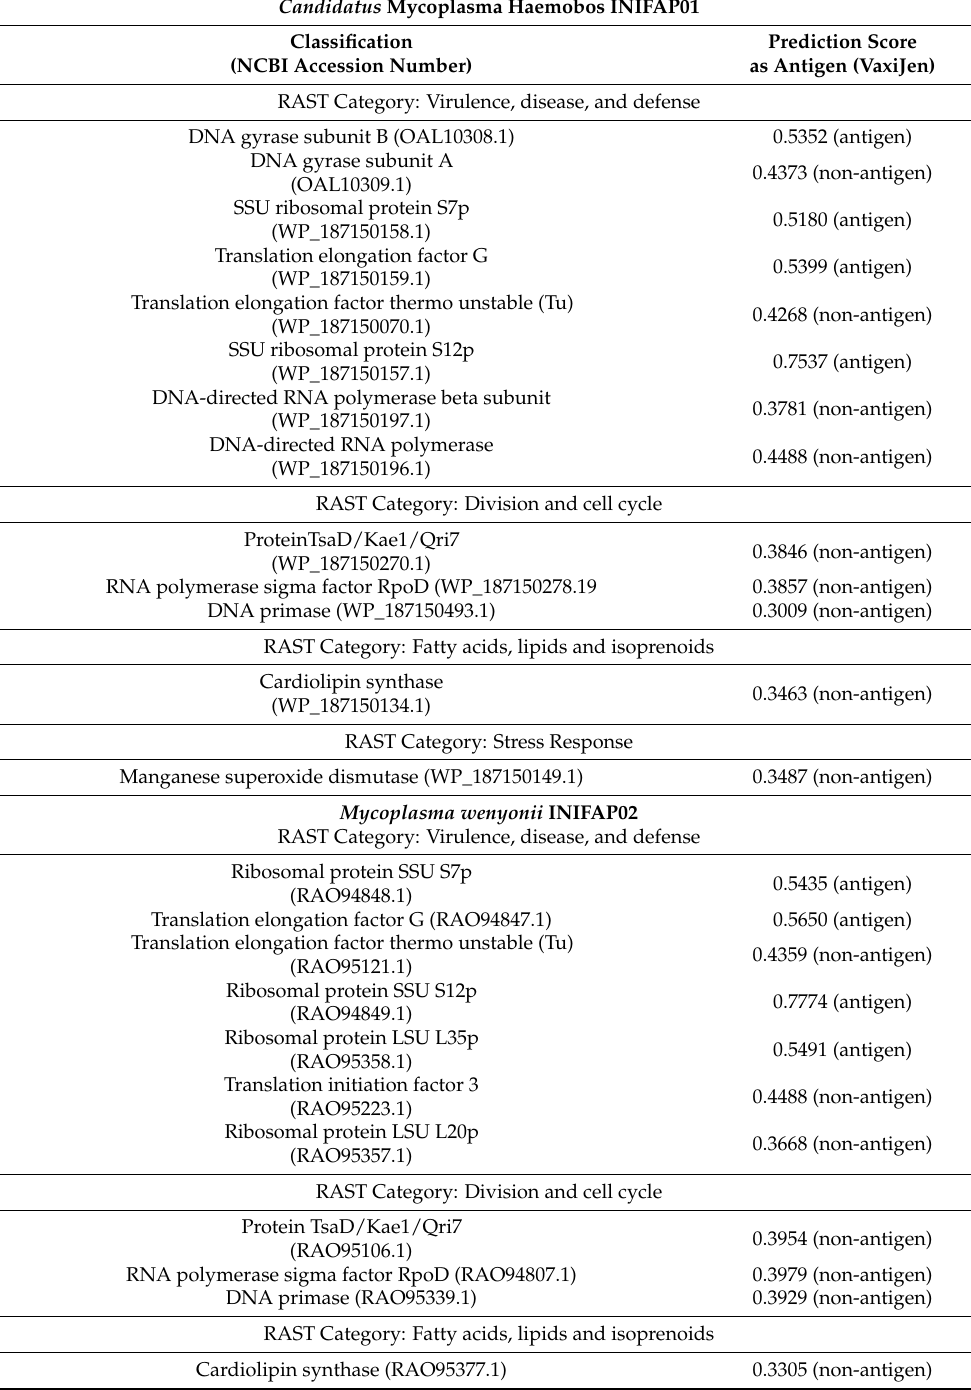
Table 2. Prediction of antigenicity of proteins of Ca . M. haemobos and M. wenyonii . Candidatus Mycoplasma Haemobos INIFAP01 Classification (NCBI Accession